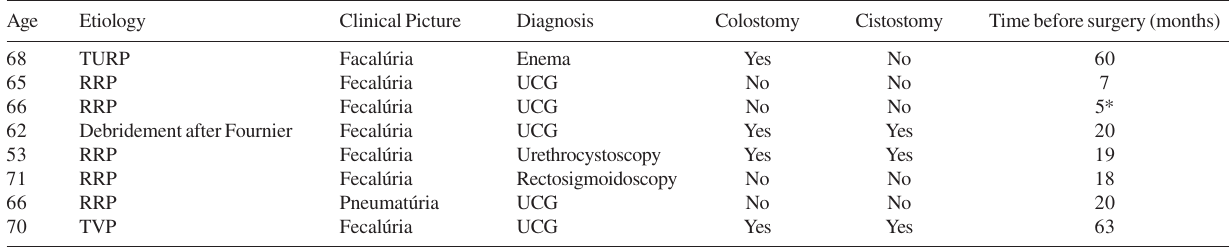
* Spontaneous closure of the fistula.